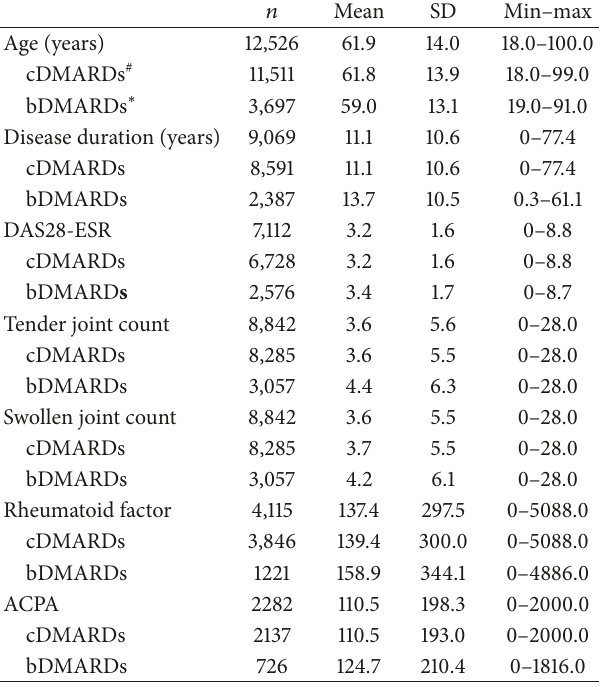
Table 1: Patient demographics and disease